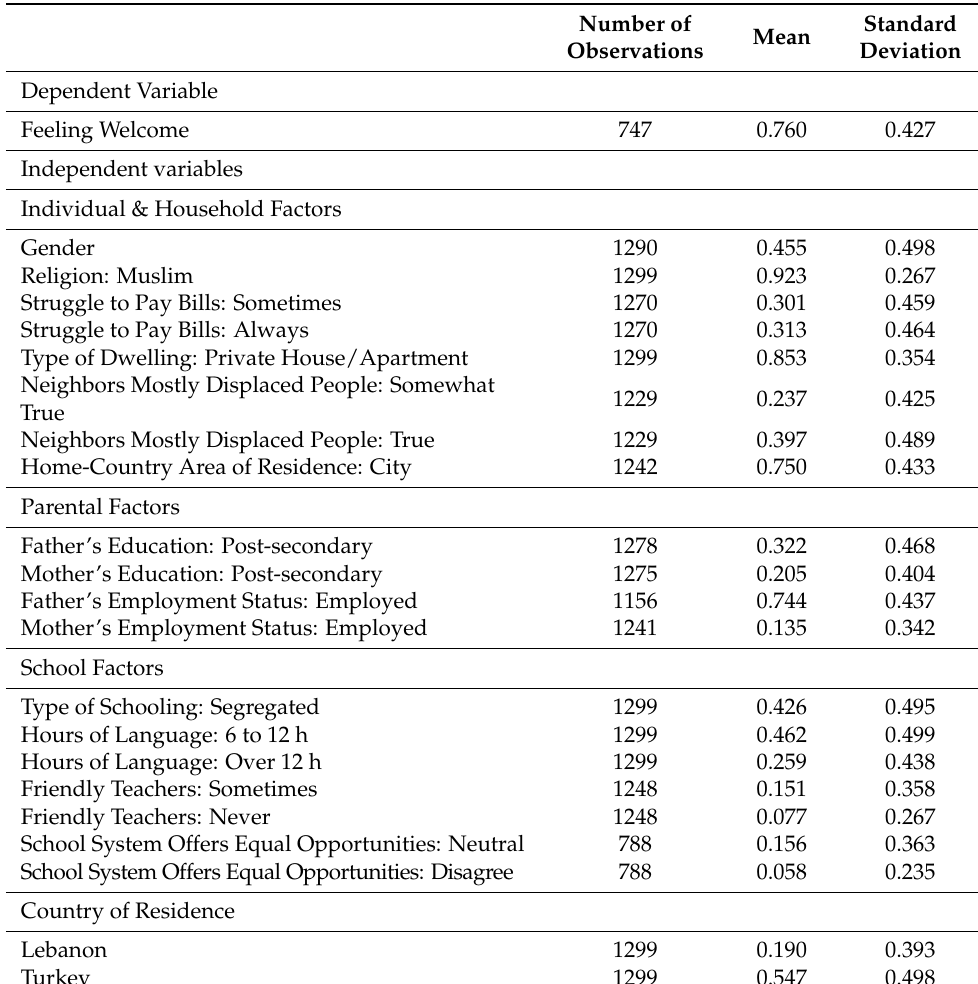
Table 1. Summary Statistics of